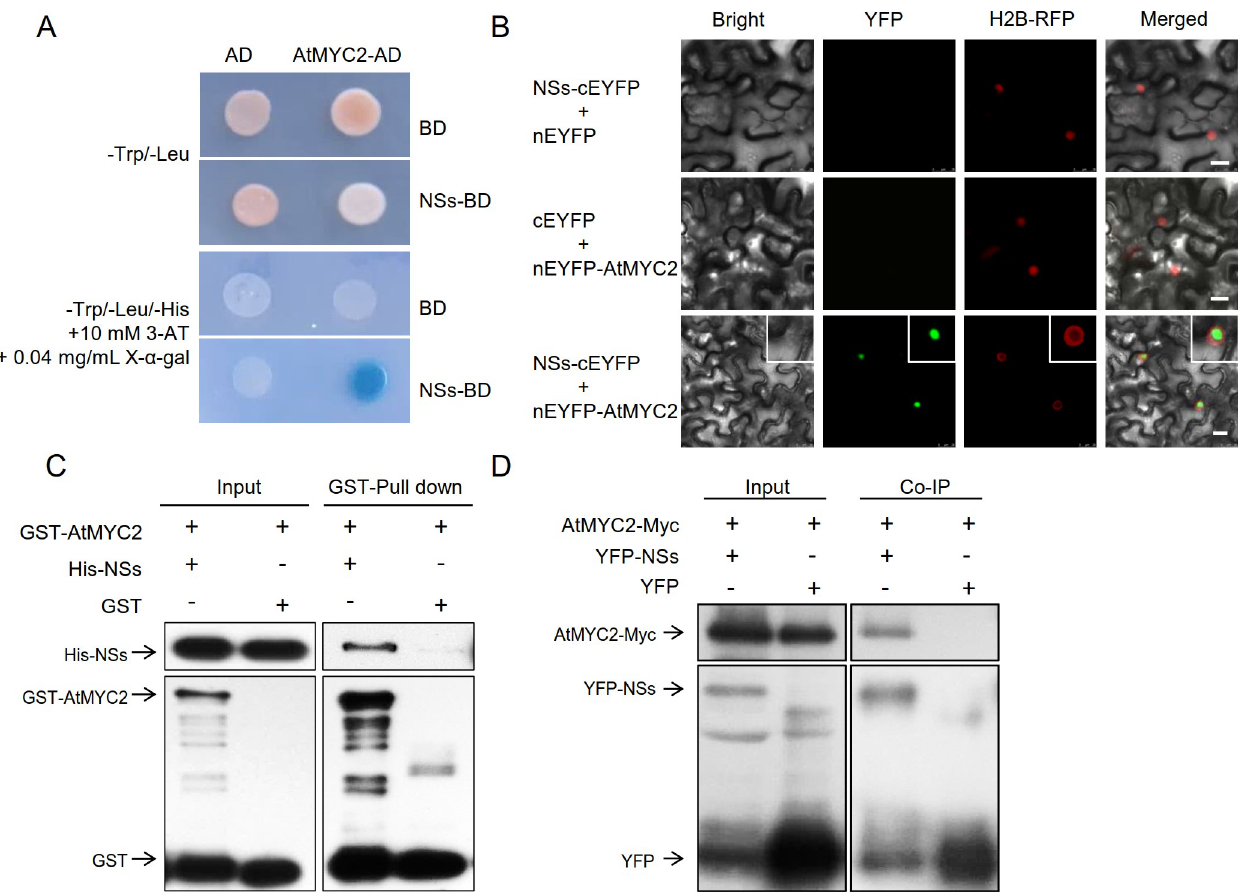
Fig 4. TSWV NSs interacts with MYC2. (A) Yeast two-hybrid assay between NSs and AtMYC2. Yeast cotransformed with the indicated plasmids was spotted onto synthetic medium (SD-Leu-Trp-His) containing 0.04 mg/mL X- α -gal and 10 mM 3-amino-1,2,4-triazole (3-AT). The empty vectors pGBKT7 (BD) and pGADT7 (AD) were used as negative controls. (B) Bimolecular fluorescence complementation (BiFC) assay. NSs-cEYFP and nEYFP-AtMYC2 were transiently expressed in H2B-RFP transgenic N . benthamiana leaf epidermal cells via agroinfiltration. Bars = 15 μ m. (C) GST pull-down assays between NSs and AtMYC2. (D) Interaction between NSs and AtMYC2 in Co-immunoprecipitation (Co-IP) assay. Total protein was extracted from N . benthamiana leaves transiently expressing 35S : MYC2-Myc together with 35S : YFP-NSs or 35S : YFP alone. GFP-trap beads were used to precipitate the interaction complex, Anti-GFP and Anti-Myc antibodies were using to detect the immunoprecipitates.